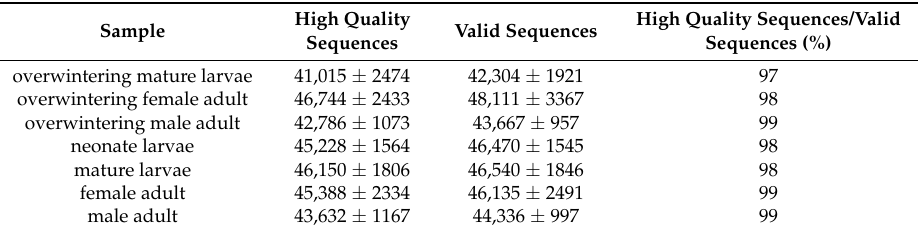
Table 1. Sequences generated before and after quality